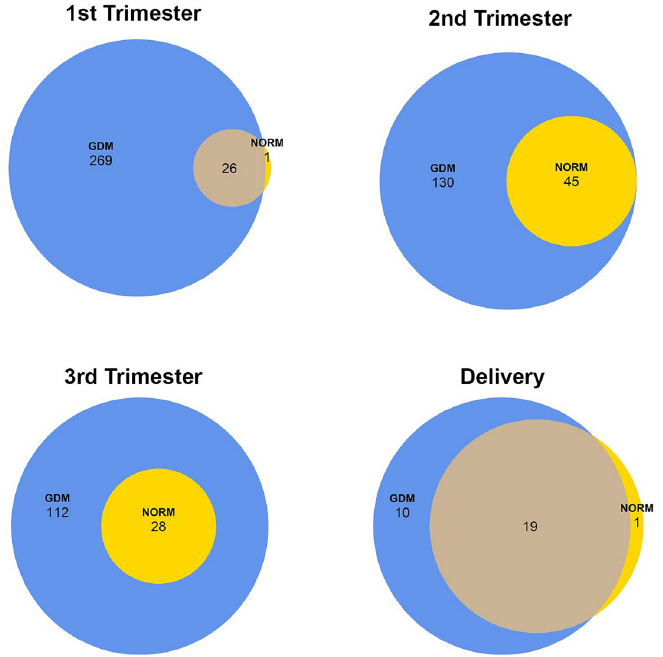
Fig 2. Differentially abundant EV-associated miRNAs at three trimesters of gestation and delivery in normal and gestational diabetes mellitus (GDM) pregnancies. Venn diagrams display the number of differentially abundant miRNAs in EVs isolated from normal pregnant (NORM) or gestational diabetes mellitus (GDM) samples compared to non-pregnant (NP) samples in (A) first trimester, (B) second trimester, (C) third trimester and (D) at delivery. Yellow represents Normal pregnancy and blue GDM. All represented genes had a log2 fold-change � 1 or � − 1 and FDR < 0.05. The FDR was calculated in DESeq2 using the Benjamin-Hochberg correction [22].